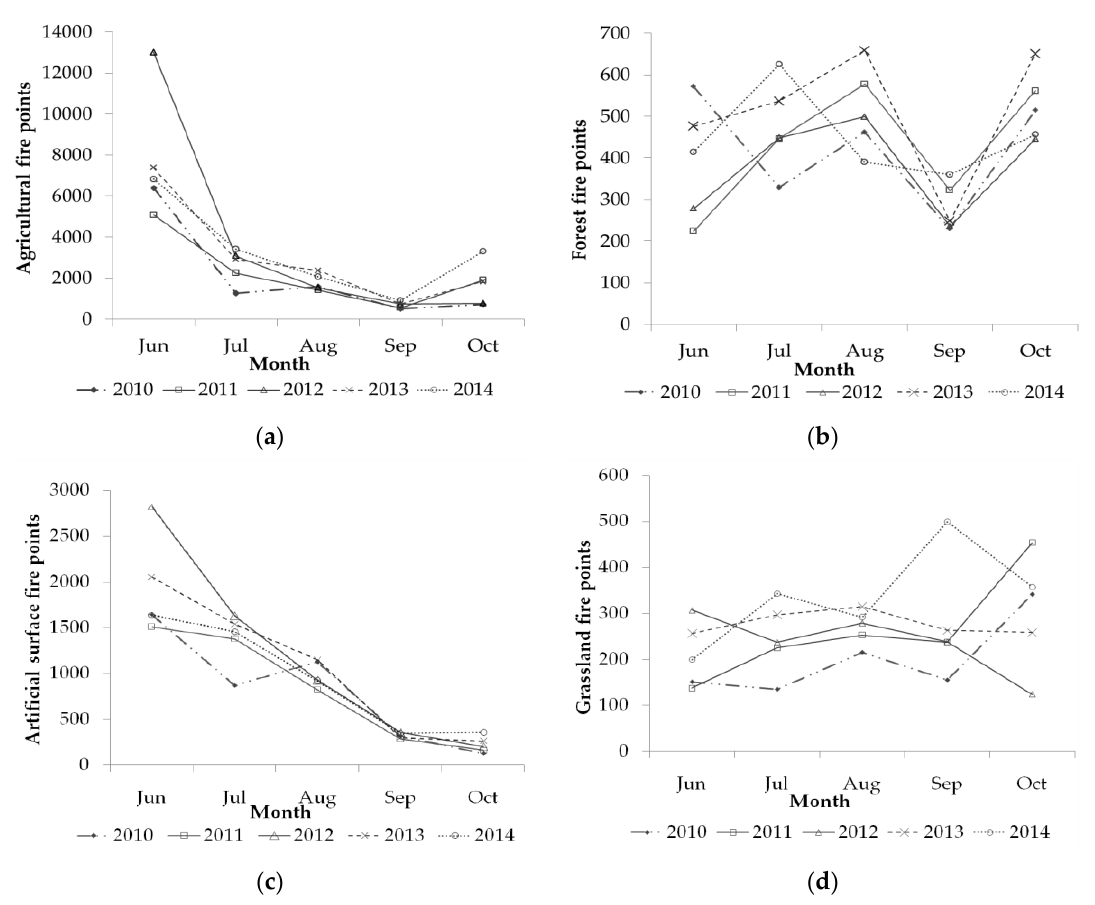
Figure 3. Monthly distribution of the fires in China within the predominant land cover types from 2010 to 2014: ( a ) agricultural fires; ( b ) forest fires; ( c ) artificial surface fires; ( d ) grassland fires.